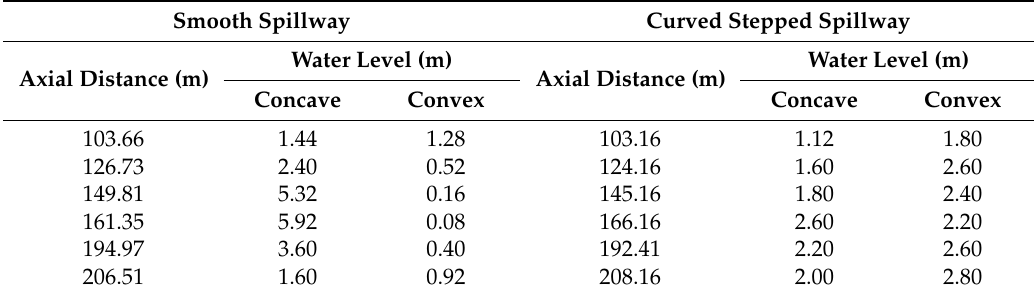
Table 3. The cross-sectional velocity distribution of the curved stepped spillway at a flow discharge rate of 272.0 m 3 /s of the prototype.